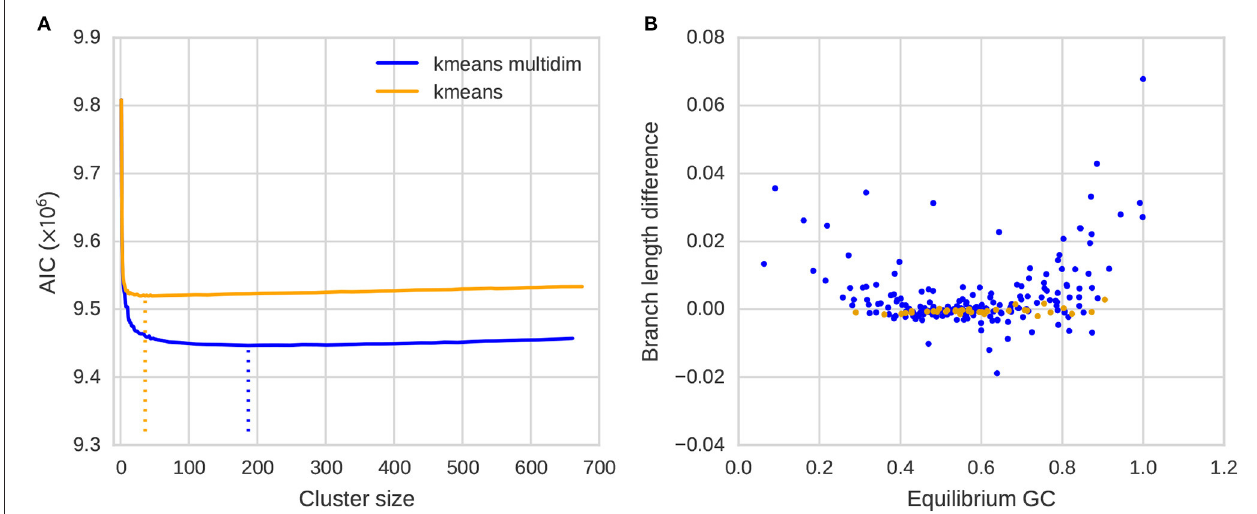
FIGURE 8 | K-means clustering on GC content per gene. Clustering was conducted using a k-means implementation according to great tit GC content (kmeans) and according to terminal GC contents of the three species (kmeans multidim). (A) AIC of the GTR-NH model under varying cluster numbers. The optimal cluster numbers derived from the GTR-NH model fit are indicated with a dotted line. (B) Branch length estimate difference and equilibrium GC for the optimal clusterings (kmeans and kmeans